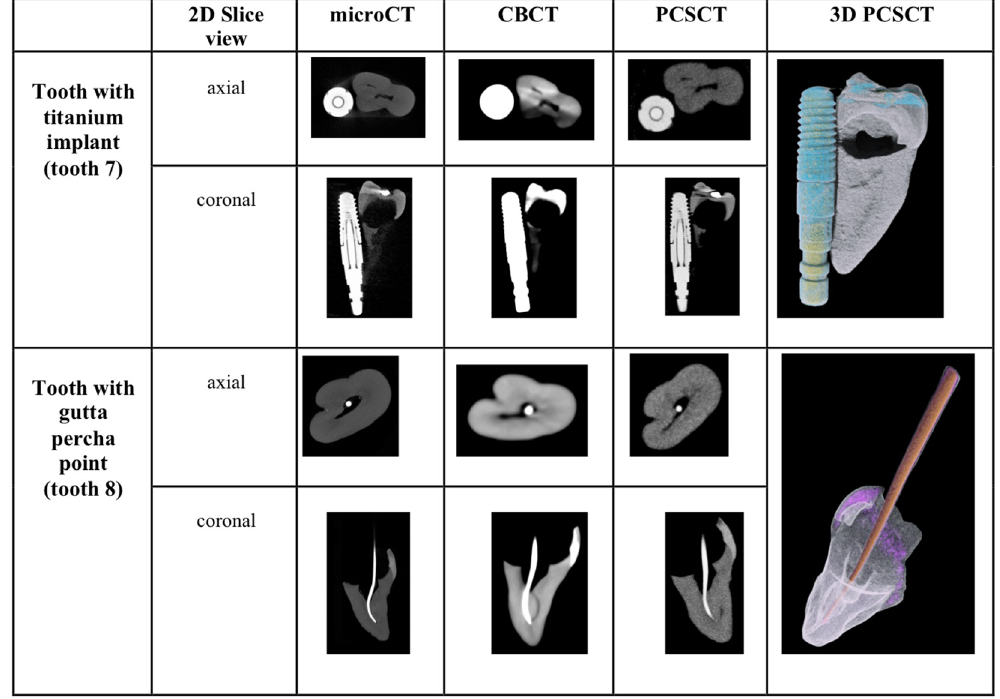
Fig. 4 Representative 2D microCT, CBCT, and PCSCT image, for teeth 7 and 8. The 3D PCSCT images are also